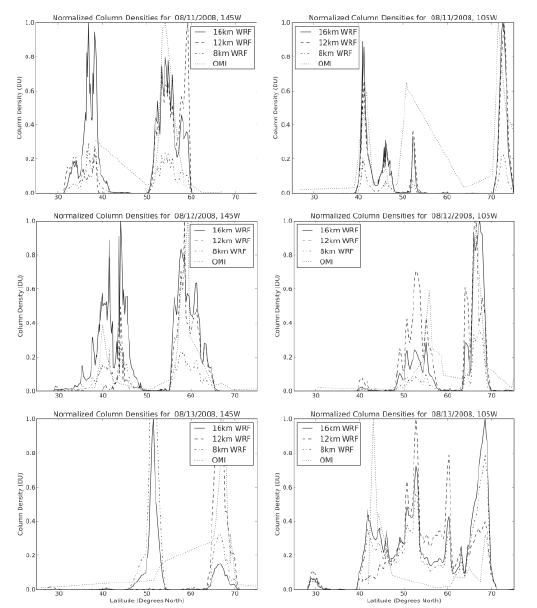
Figure 2: Spatial comparisons of SO 2 column densities from WRF-Chem using 8, 12 and 16 km initialized plume heights and from the OMI STL product.